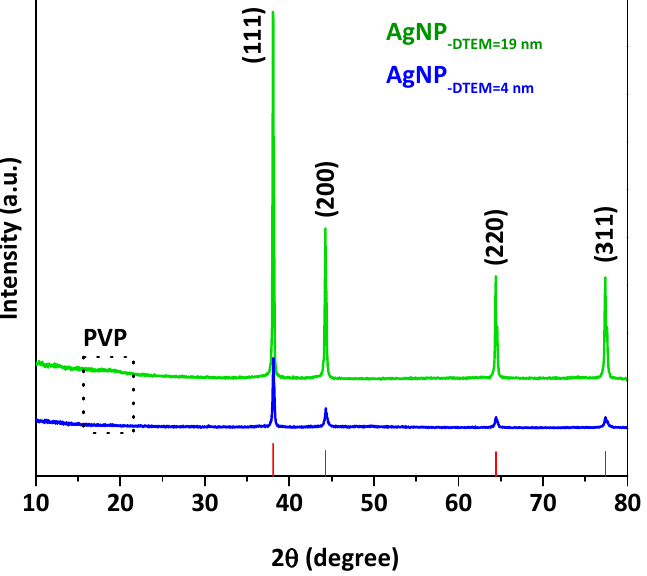
Figure 2. X-ray diffraction (XRD) patterns of AgNP with average diameters of 19 nm (green) and 4 nm (blue), compared to the XRD pattern of the Ag FCC crystal structure (JCPDS card No. 04-0783). As shown in Figure 3, FTIR spectra of both samples show similar absorption bands, which is due to sharing the same composition of surfactants/stabilizing agents in the synthesis process. The double absorption bands located at 3410 and 3300 cm − 1 are at- tributed to the O-H stretching vibration peak of PVP [28] and to the absorption peak of N-H stretching vibration of PEI [29], respectively. Moreover, two adsorption bands can be observed at 2950 and 2851 cm − 1 that can be related to the asymmetric and